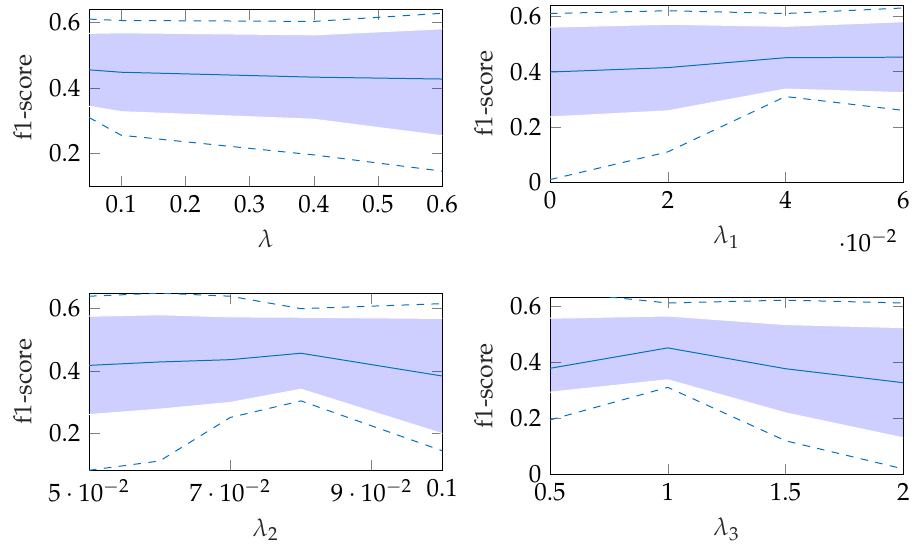
Figure 11. Effect of changing segmentation parameter for automatic segmentation, where the dashed lines show the minimum and maximum f1-score values and the standard deviation is indicated by the filled